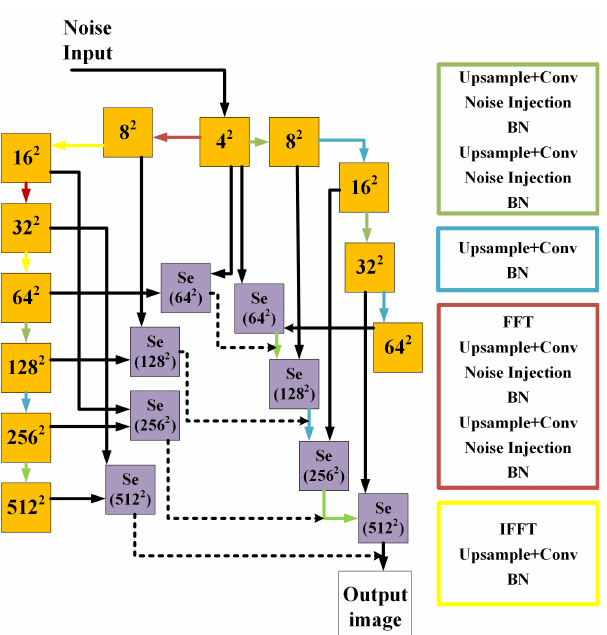
Figure 3. The structure of the generator. The solid orange boxes represent the feature maps with the spatial size. The blue box and arrows indicate the structure of up-sampling. The green box and arrows depict the similar up-sampling process with additional noise. The red box and arrows indicate the structure containing FFT. The yellow box and arrows represent the structure that contains the IFFT. The solid purple boxes represent the SeBlock, which has the same structure as in the discriminator, only adjusting some parameters. The dotted line represents adding two images with different